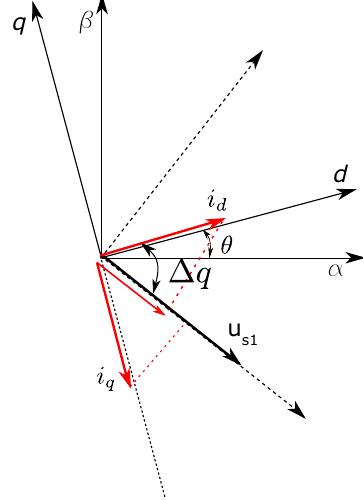
Figure 10. Vector diagram illustrating PLL dynamics under fast